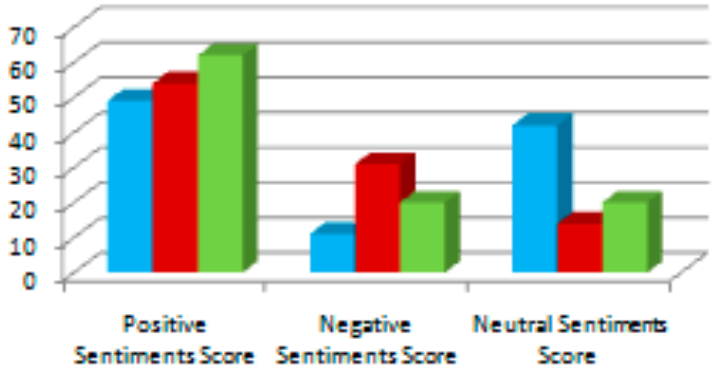
Figure 5. Sentiment comparison for all queries.